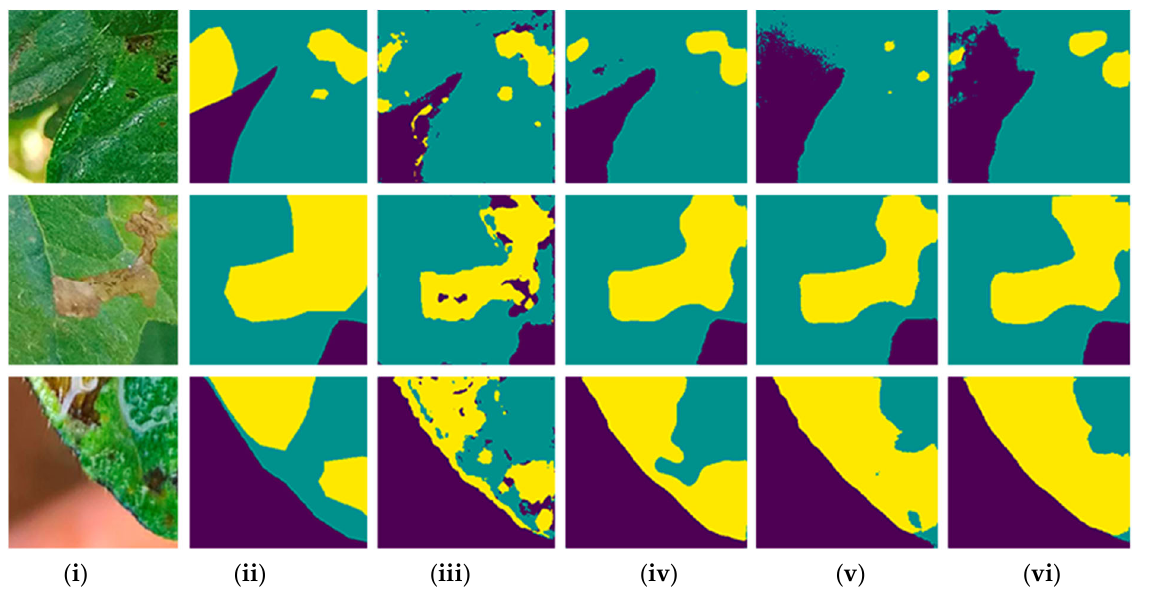
Figure 5. Visual comparison of the results of the multiclass semantic segmentation from the U ‐ Net model performed on the testing database. ( i ) Original image, ( ii ) reference annotation, ( iii ) VGG16, ( iv ) DenseNet121, ( v ) Inceptionv3, ( vi ) ResNet34. The background class is purple, the tomato leaf class is green, and the leafminer fly symptom class is yellow.